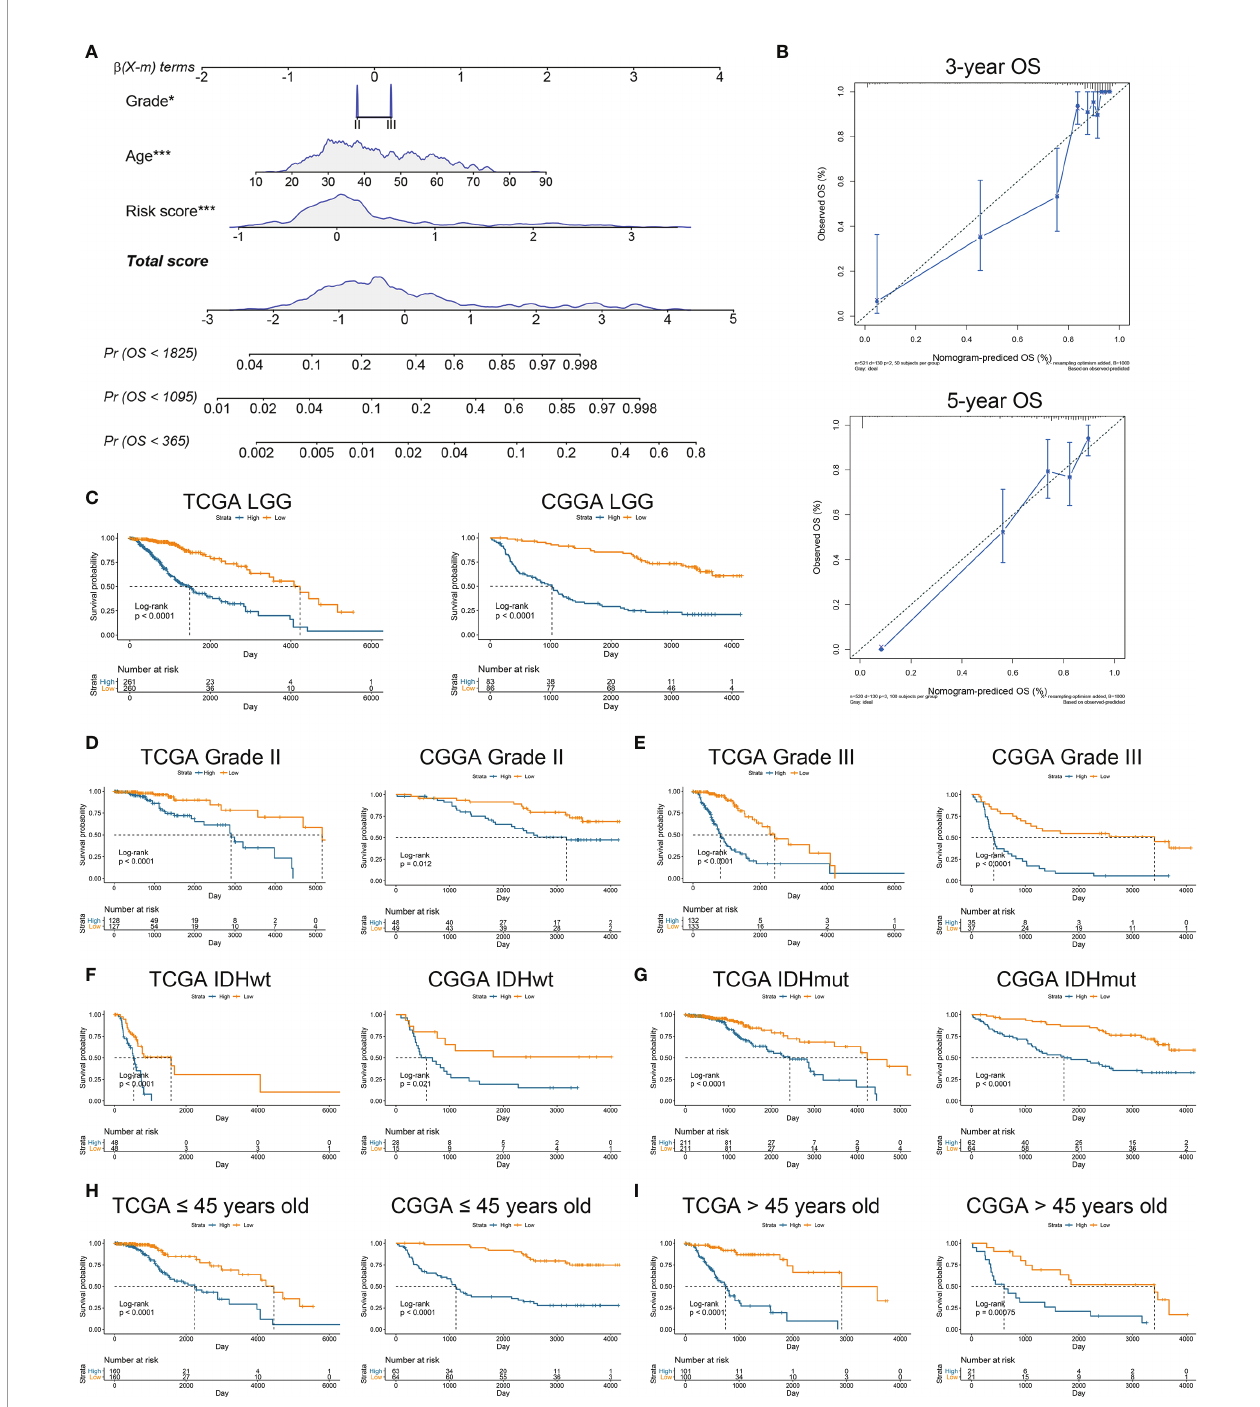
FIGURE 3 | Risk signature was associated with the prognosis of LGG patients. (A) Nomogram model of grade, age, and risk score in the TCGA dataset. (B) Calibration curve model to verify the predictive value of risk score regarding 3-year and 5-year survival. (C) Kaplan-Meier analysis of high-score and low-score in LGG patients. (D, E) Kaplan-Meier analysis of high-score and low-score patients in grade II (D) and grade III (E) gliomas. (F, G) Kaplan-Meier analysis of high-score and low-score patients in IDH wildtype (F) and IDH mutant (G) gliomas. (H, I) Kaplan-Meier analysis of high-score and low-score patients ≤ 45 years old (H) or >45 years old (I) in diffuse